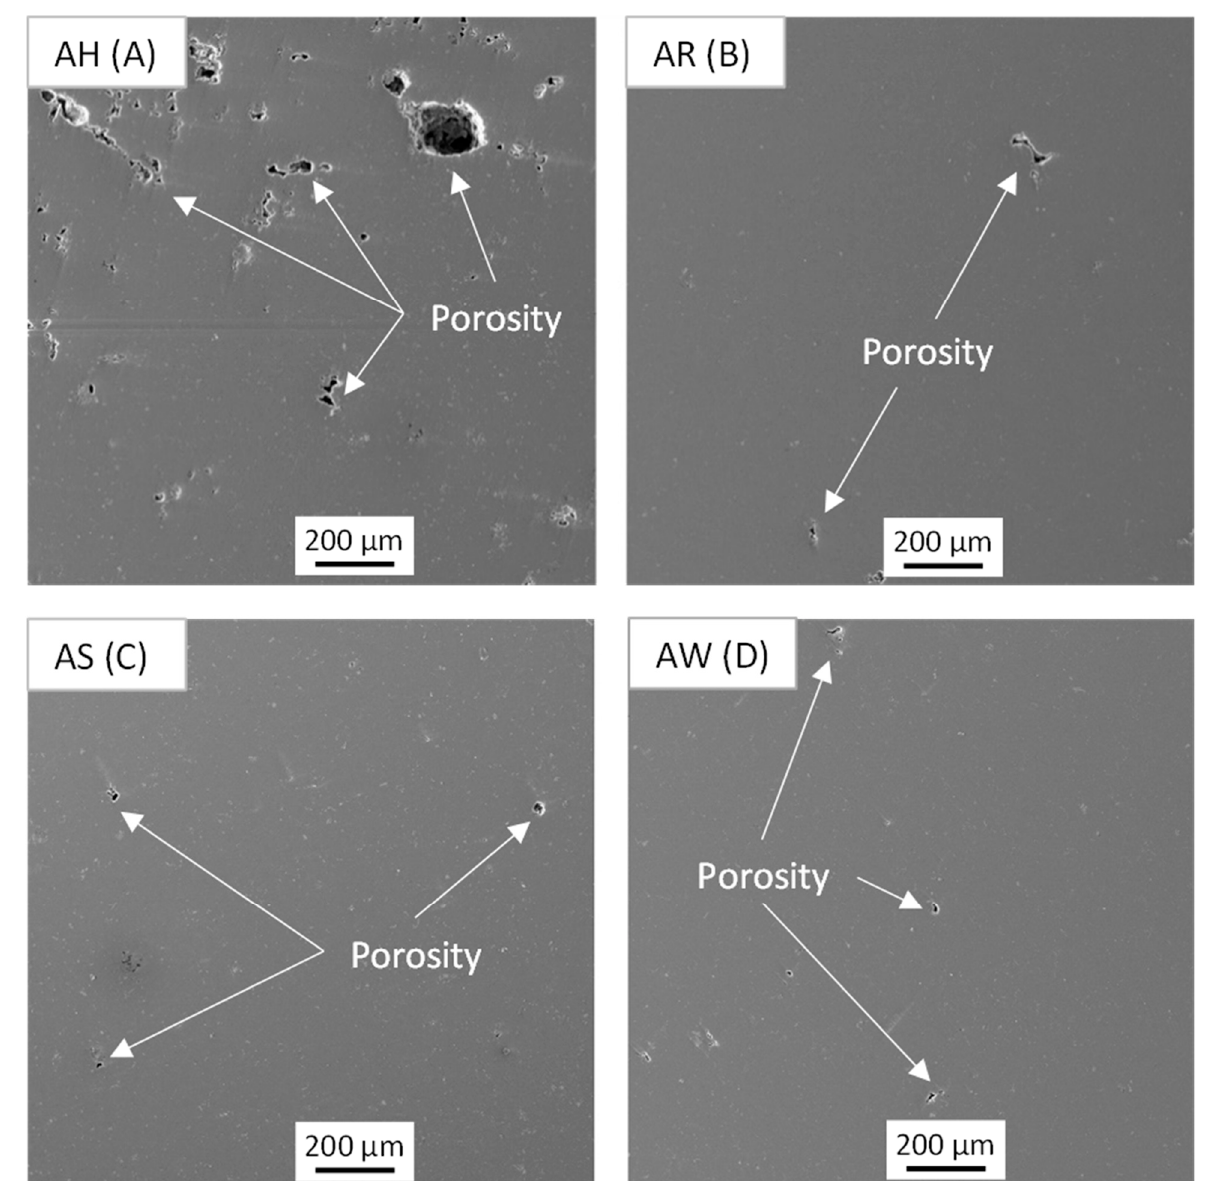
Figure 6. Representative un-etched micrographs for various regions of the as-cast component showing the presence of porosities: ( A ) AH specimen; ( B ) AR specimen; ( C ) AS specimen; and ( D ) AW specimen.